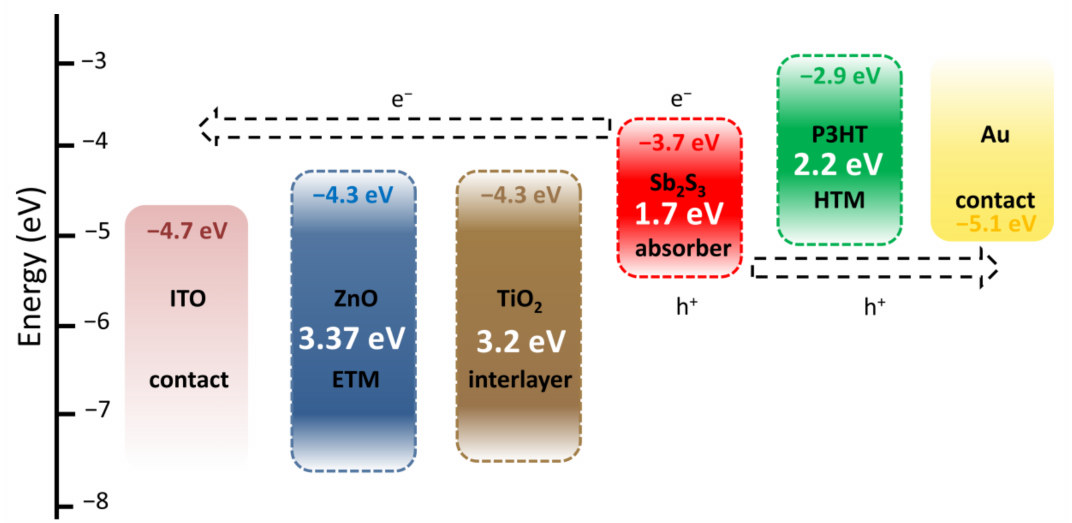
Figure 6. Architecture and corresponding diagram of energy levels of ZnO/TiO 2 /Sb 2 S 3 core–shell NW heterostructure-based ETA solar